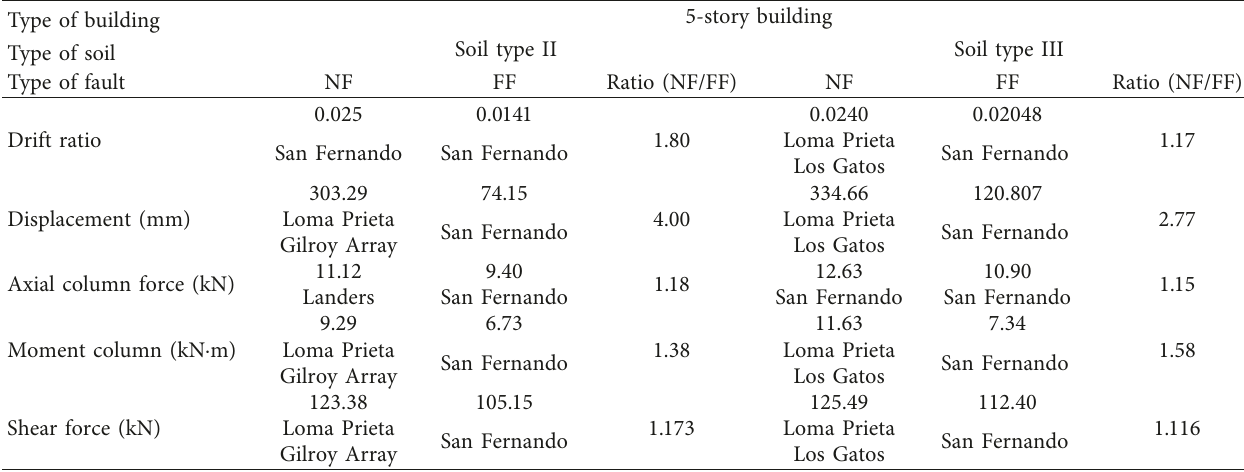
Table 15: A comparison of the maximum drift ratio, displacement, base shear, and moment of columns due to near-field earthquakes with progressive direction-taking and in far-field earthquakes.